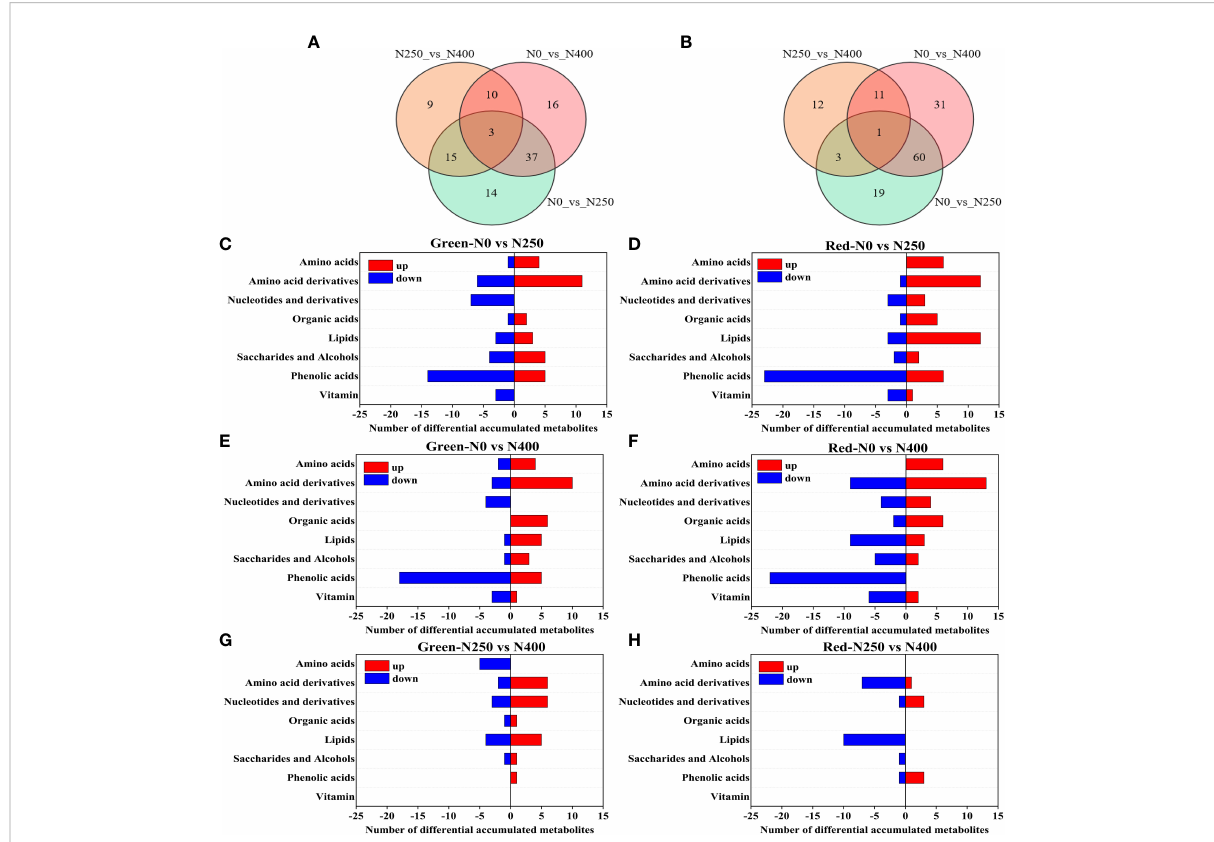
FIGURE 3 Venn diagram depicting the common and speci fi c differential accumulated metabolites (DAMs) in the pericarp of pepper fruits between pairs of N levels at mature green (A) and red (B) stage, and the classi fi cation of DAMs in the pericarp of pepper fruits in comparison of N0 vs N250 (C) , N0 vs N400 (E) and N250 vs N400 (G) at mature green stage, and N0 vs N250 (D) , N0 vs N400 (F) and N250 vs N400 (H) at mature red